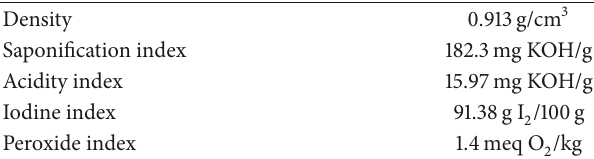
Table 1: Physicochemical parameters of the raw